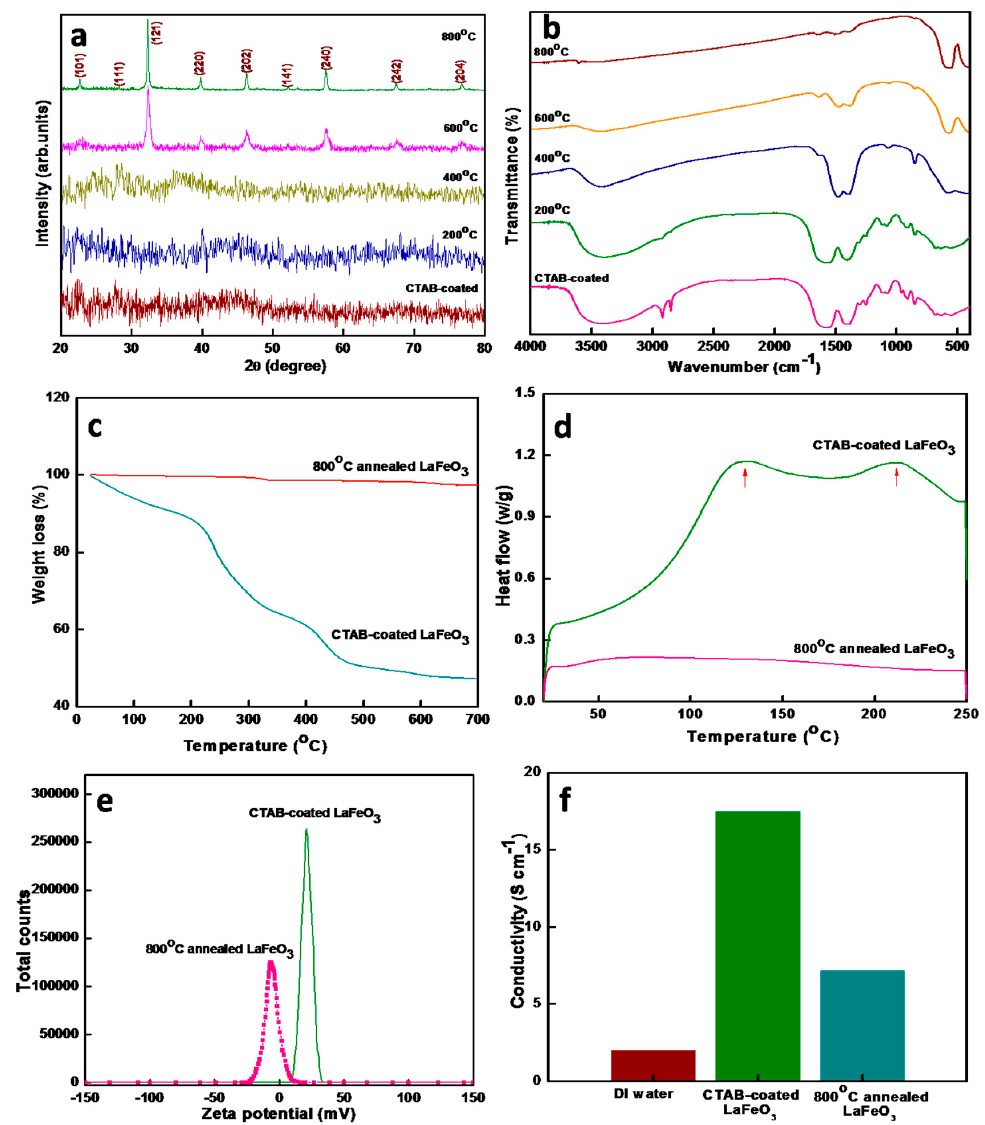
Figure 2. ( a ) X-ray diffraction (XRD) patterns; and ( b ) Fourier transform infrared spectroscopy (FTIR) spectra of CTAB-coated LaFeO 3 nanoparticles and those annealed at various temperatures; ( c ) thermo-gravimetric analysis (TGA) thermographs; ( d ) differential scanning calorimetry (DSC) thermographs; ( e ) zeta potential plot; and ( f ) conductivity of CTAB-coated and 800 °C annealed LaFeO 3 nanoparticles. Plots ( e , f ) are measured on nanoparticles in distilled water suspensions.